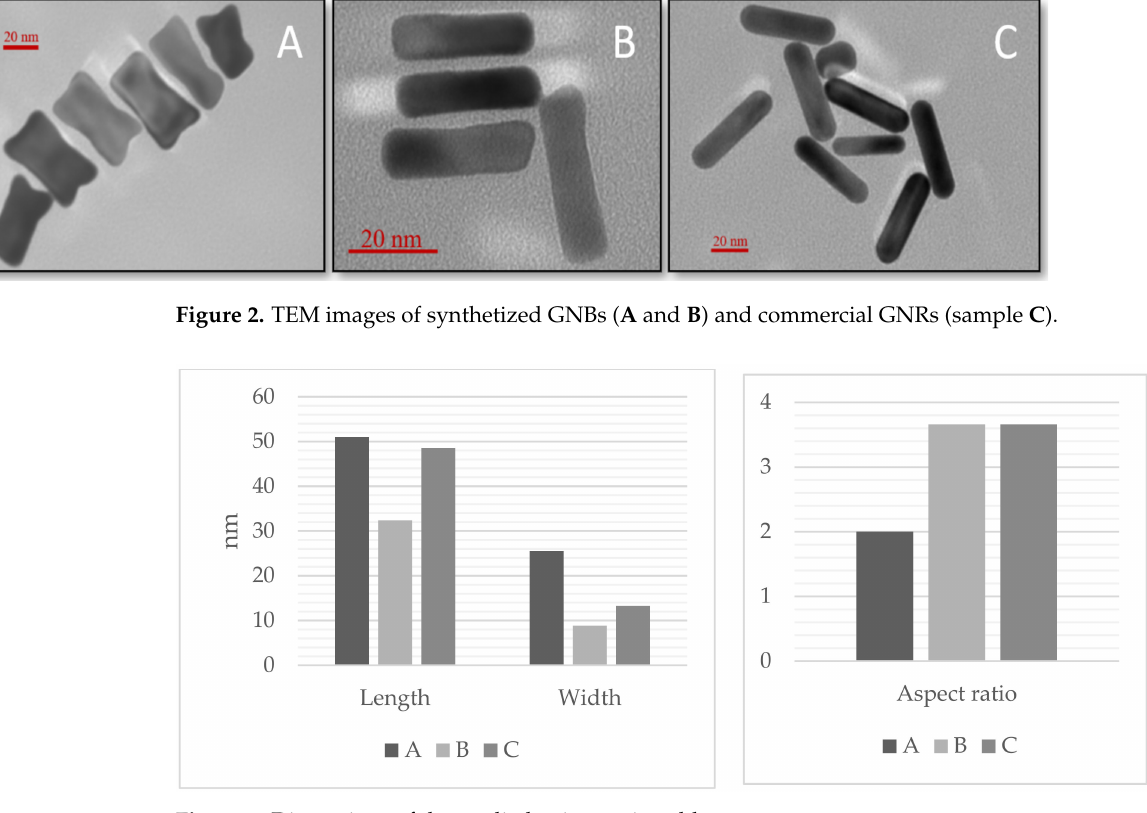
Figure 3. Dimensions of the studied anisotropic gold